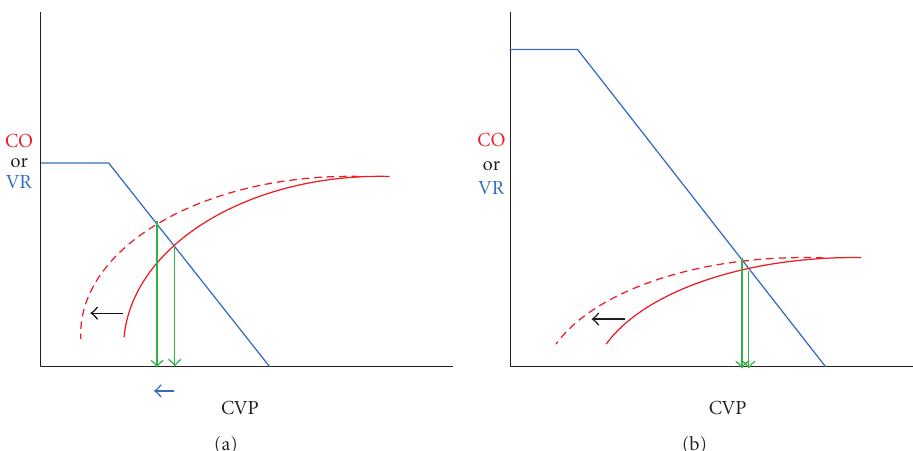
Figure 1: During spontaneous breathing the cardiac function curve (solid red curve) is shifted to the left (dashed red curve). When the heart is functioning on the ascending part of the cardiac function curve. CVP falls (blue arrow) and CO rises ((a), on left). However, when the heart function is depressed or the circulation is volume loaded ((b), on right), CVP and CO remain unchanged. CVP : central venous pressure, CO: cardiac